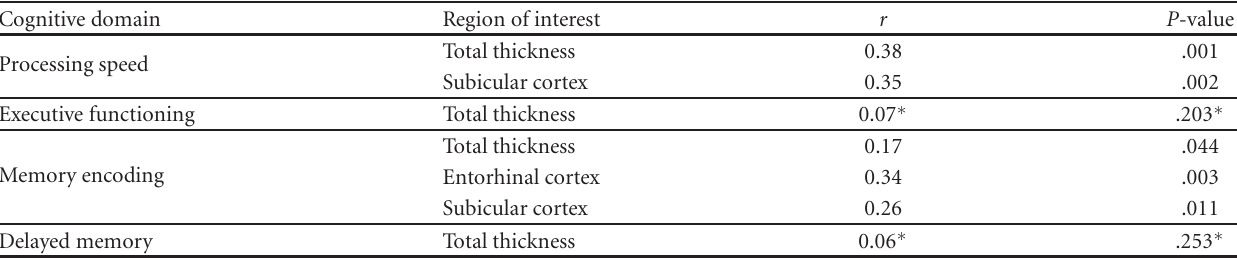
Table 3: Pearson Correlation Coe ffi cients ( r ) and P -values for correlations between Cognitive Domains and Total Thickness averaged across all subregions studied in the MTL as well as the subregions within the MTL that were significantly correlation to the Domain